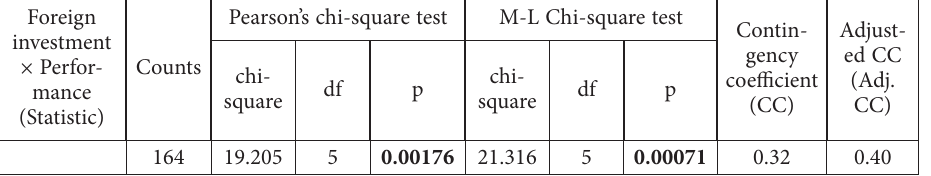
Table 3. Contingency: foreign ownership × performance – statistics (source: own) Foreign investment